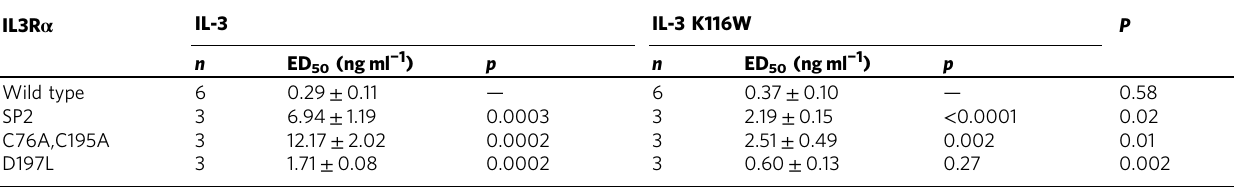
Table 3 Enhanced site 1a interactions do not fully compensate for perturbations of functional interactions through the NTD